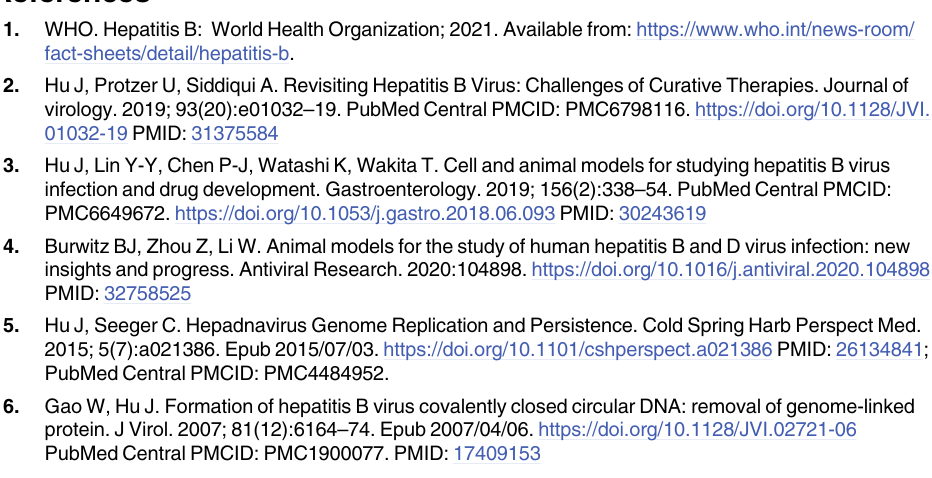
S3 Dataset. IPA analysis of canonical pathway on differentially expressed genes between WC3-huNTCP and WCH-17-huNTCP cells. S4 Dataset. List of genes differentially expressed between WC3 and WCH-17 huNTCP- expressing cells that are associated with intracellular transport (GO: